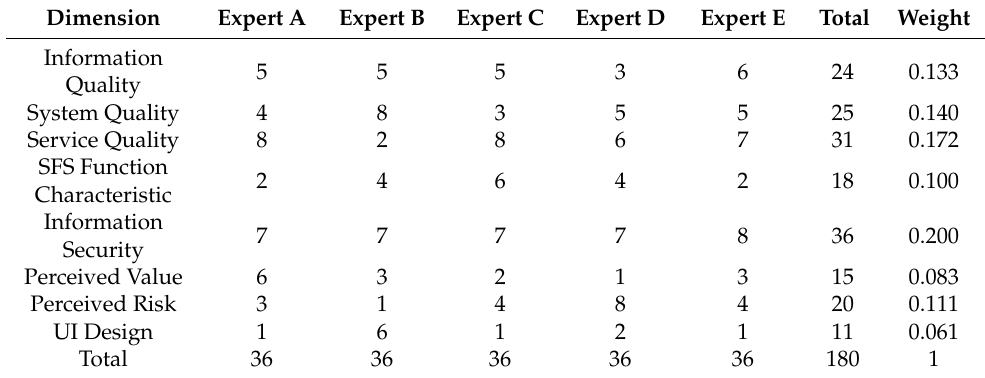
Table 5. The weight of dimensions for SFS.